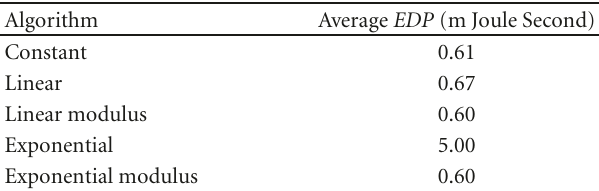
Table 2: Average EDP